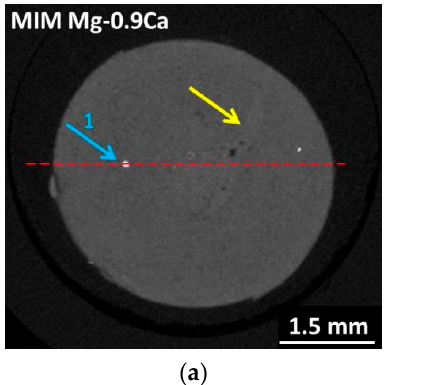
Figure 5. Identical MIM Mg-0.9Ca specimens sintered on three different levels in a furnace suffering from ±12 K temperature deviation.